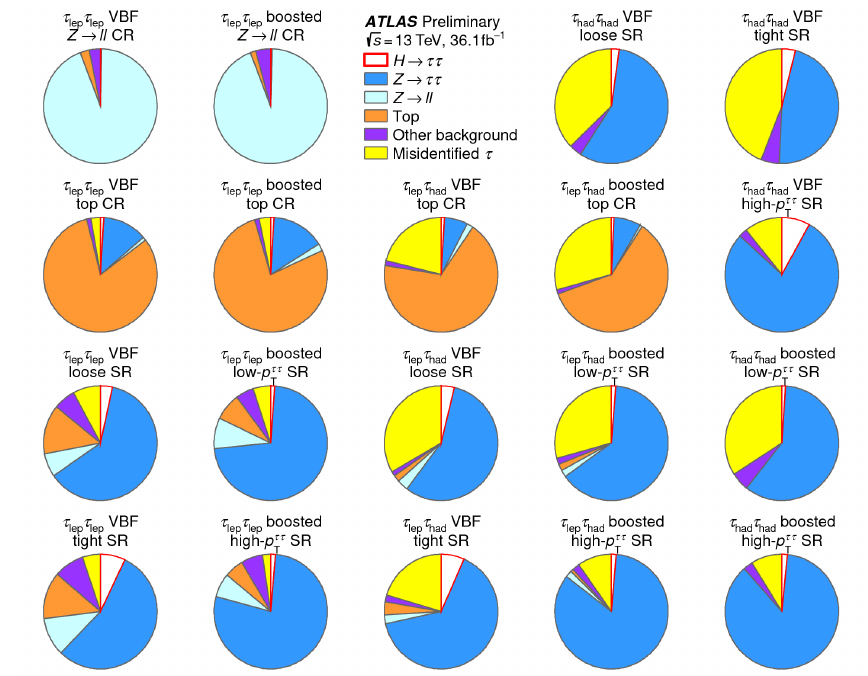
Figure 1: Expected signal and background composition in the 13 signal regions (SRs) and the six control regions (CRs). [ 7